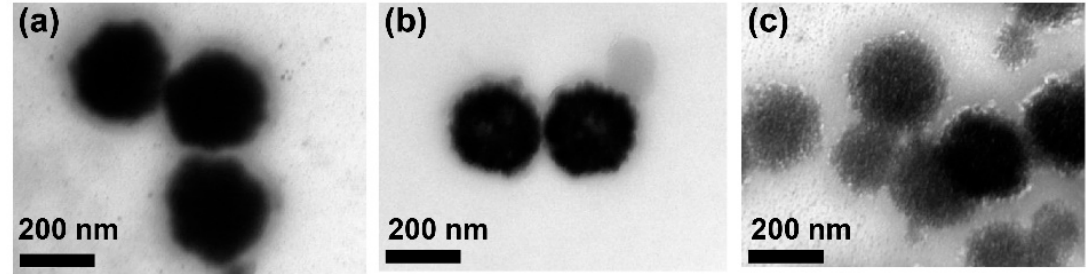
Figure 8. TEM images of HPNCs for various polymer concentrations: ( a ) 5 mg/mL; ( b ) 3 mg/mL; ( c ) 1 mg/mL.